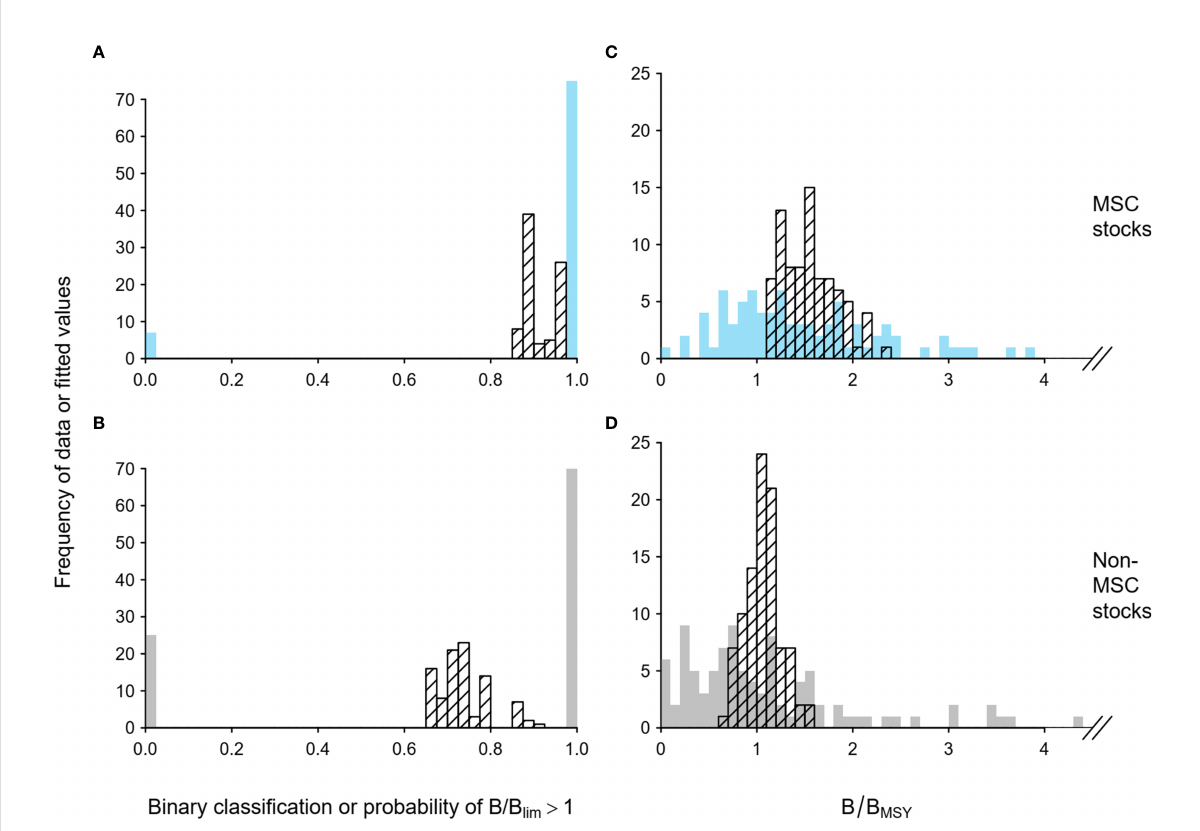
FIGURE 4 Frequency distributions of observed and model- fi tted values of relative biomass variables for MSC stocks (n = 82) and non-MSC stocks (n = 95) in 2018. (A, B) Observed binary classi fi cation or predicted probability of biomass above the ‘ over fi shed ’ threshold ( B > B lim ), from portion 1 of the analysis. (C, D) Observed or predicted B / B MSY , from portion 3 of the analysis, with horizontal axes truncated at 4.5 thereby omitting one MSC stock with B / B MSY = 7.9. Solid bars (blue for MSC stocks in A , C ; grey for non-MSC stocks in B , D ) show observed values and hatched bars show model- fi tted